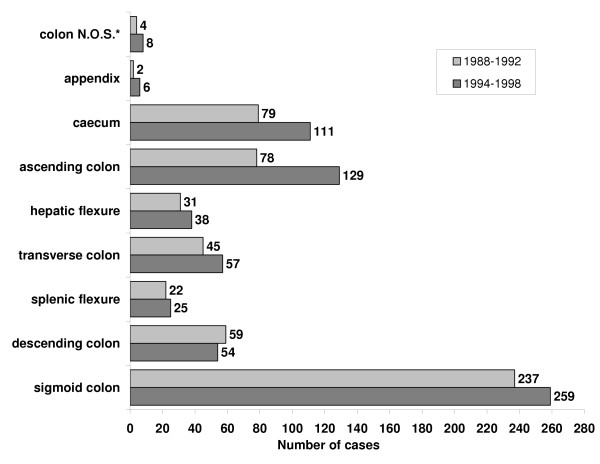
Number of invasive colonic adenocarcinomas (n = 1244; cases of the year 1993 excluded) by anatomic site; 1988–1992 and 1994–1998. (N.O.S.* = not otherwise specified)